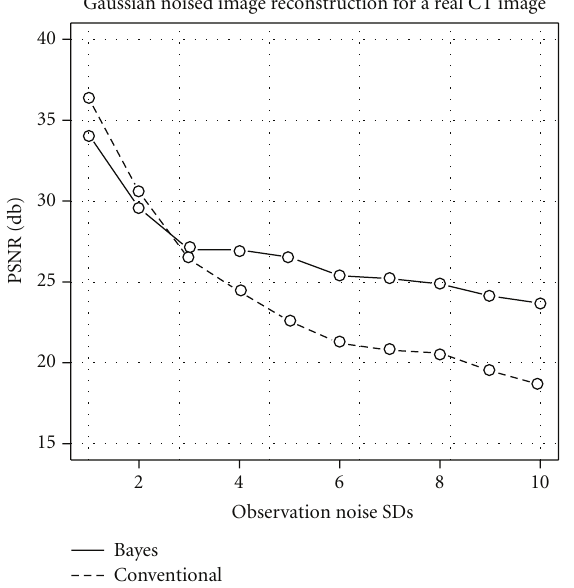
Figure 10: Qualities of reconstruction images measured by PSNR for real CT image reconstruction under the Poissonian noise. The horizontal axis shows the sampling level, and the vertical axis shows the PSNR. The solid line shows the result performance of Bayesian method, and the dashed line shows the results of the conventional FBP